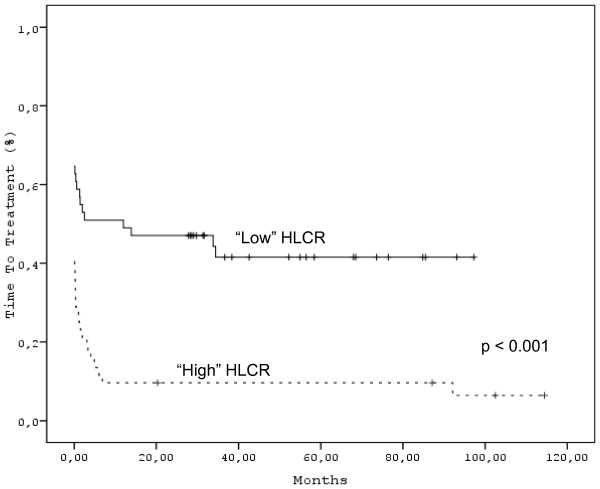
"High" or "Low" HLCR in MM patients at diagnosis.